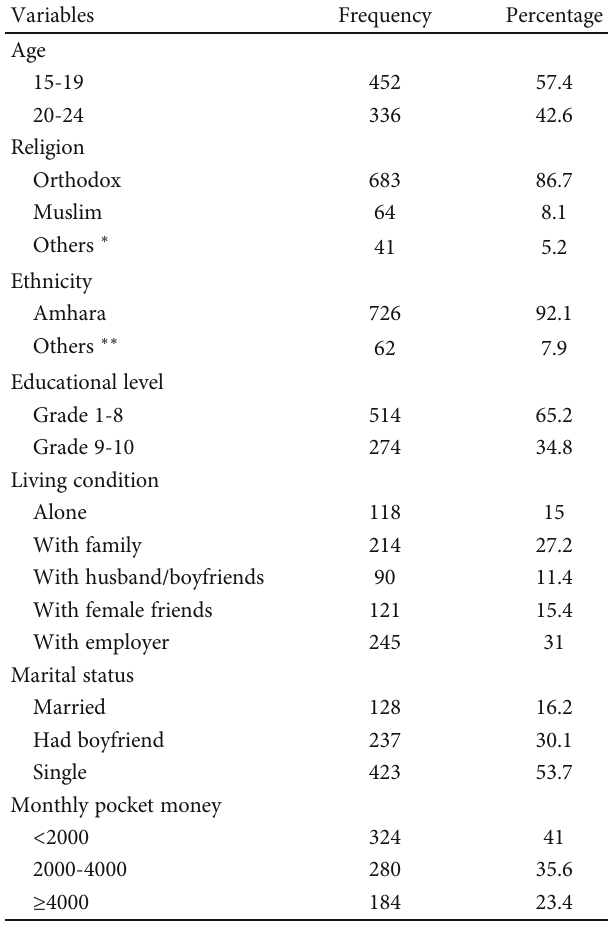
Table 1: Sociodemographic characteristic of female night students in public institution of Bahir Dar City, Amhara Region, Ethiopia,